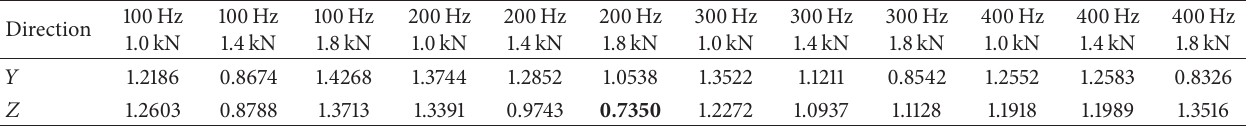
Table 6: The Margin calculated (using PIEEMD with SNR = 10), for the defective inner ring.